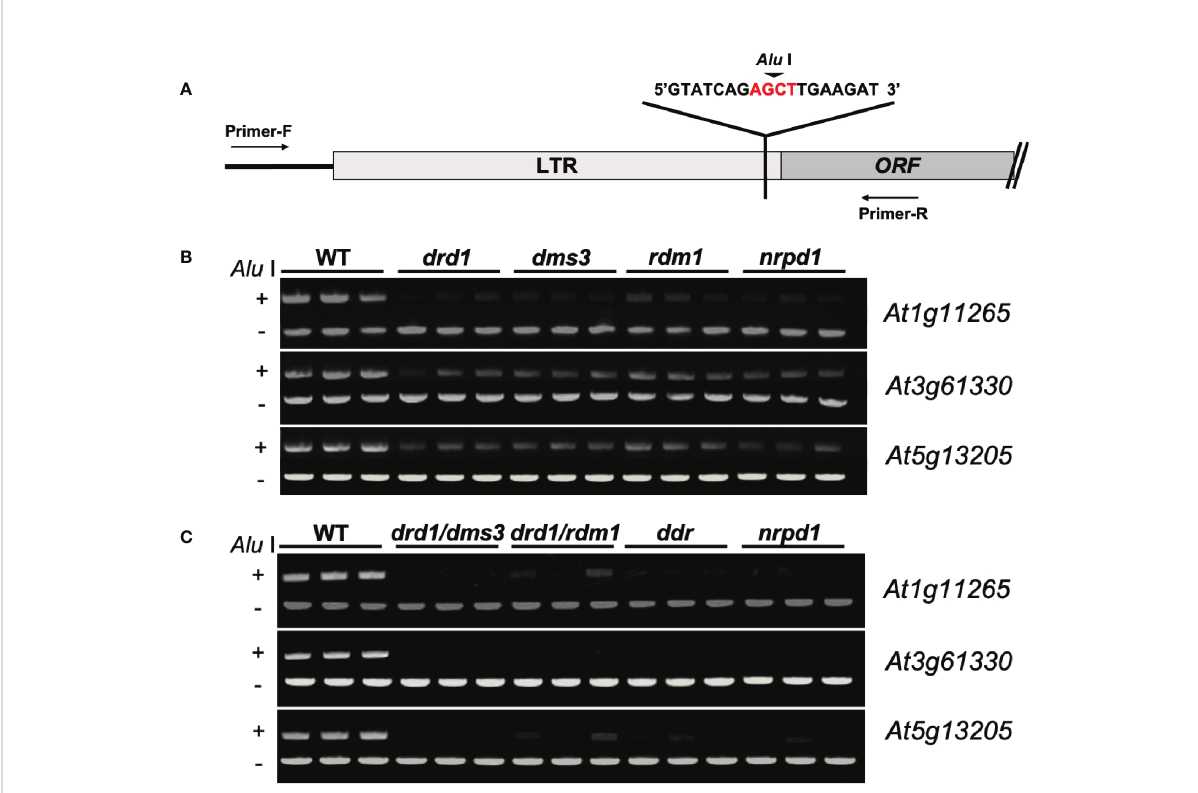
FIGURE 1 ddr deletion disrupts DNA methylation. (A) Primer sites for Chop-PCR ampli fi cation. Primers were designed to increase sequences in and around the ONSEN LTR region. AGCT is a sequence recognized by Alu I, which cuts the connection between G and C when C is not methylated. (B) ONSEN ( At1g11265 , At3g61330 , and At5g13205 ) methylation levels in the wild type and drd1 , dms3 , rdm1 , and nrpd1 mutants. (C) ONSEN ( At1g11265 , A3g61330 , and At5g13205 ) methylation levels in WT, drd1/dms3 , drd1/rdm1 , ddr and nrpd1